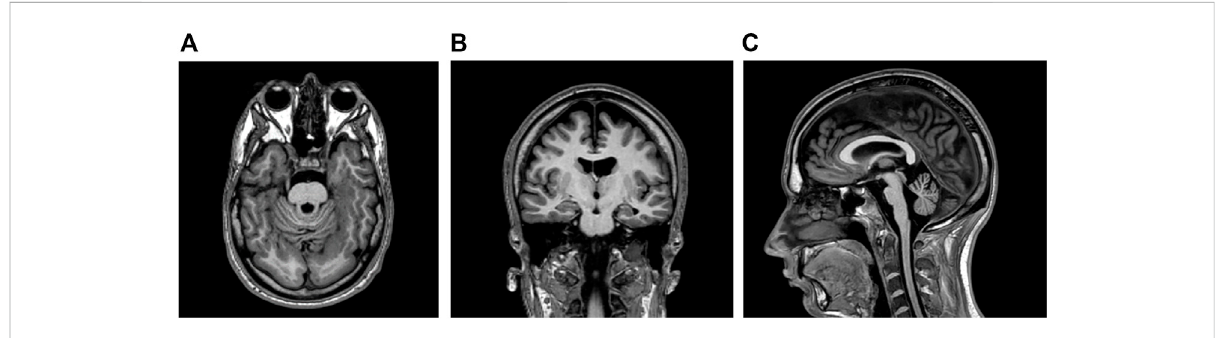
FIGURE 1 (A,B) Brain magnetic resonance imaging (MRI) showing bilateral polymicrogyria in temporal and occipital lobes (T1-weighted axial and coronal sequences respectively) (C) Atrophy in pons and cerebellum was detected in the T1-weighted sagittal